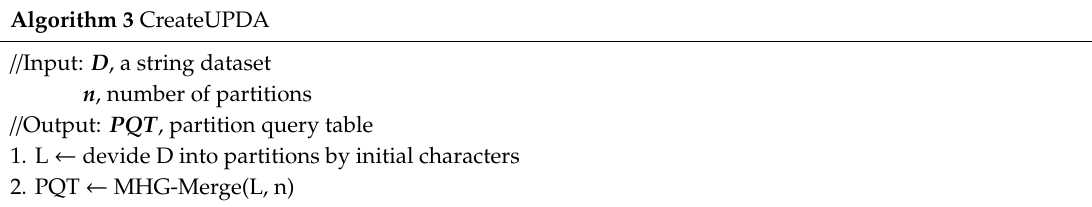
Algorithm 3. Constructing algorithm for UP-DA.